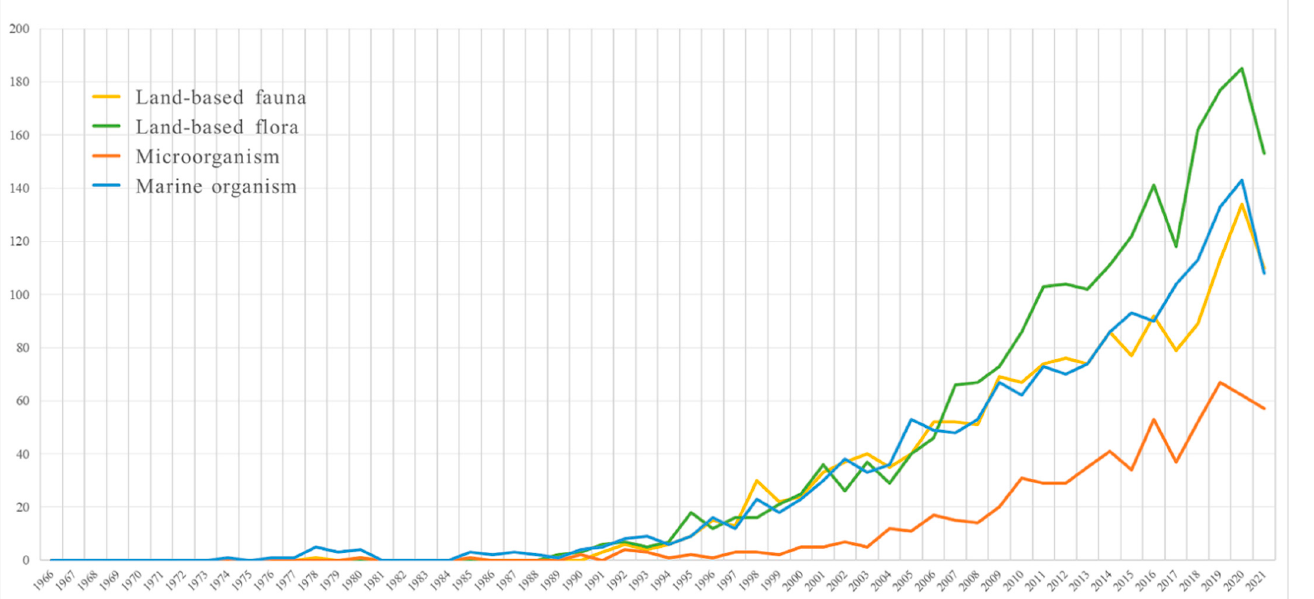
Figure 3. Search results using Web of Science (Data accessed on 22 February 2022) from 1966 to 2021, with the numbers of the published papers in each year; results include all documents and trends obtained using the keywords, “latitudinal diversity gradient” and “Land-based flora” (including plant, forest, flora, vegetation, algae, bryophyte, pteridophyte, spermatophyte, or lichen); “Land-based fauna” (including animal, zoology, fauna, vertebrate, invertebrate, bird, fish, mammal, amphibians, reptiles, or insect); “Microorganism” (including microbes, microorganism, bacteria, or germ); “Marine organism” (including marine, ocean, or sea), respectively.